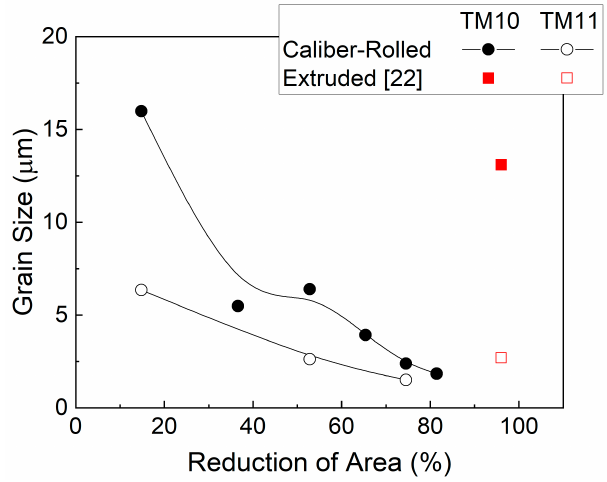
Figure 4. Grain sizes of the investigated TM10 and TM11 Mg alloys depending on the reduction in the area. Grain sizes of the extruded TM10 and TM11 Mg alloys [22] are also included for comparison.